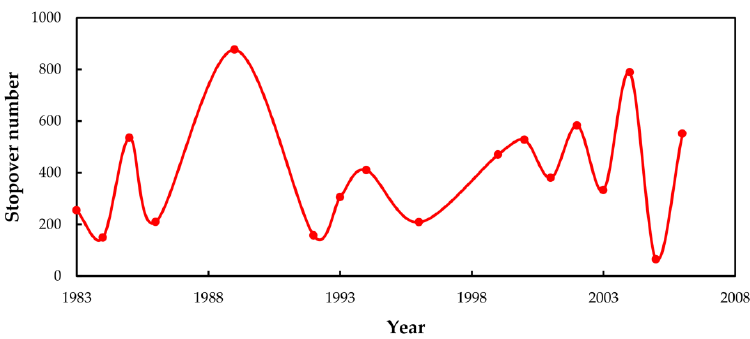
Figure 3. Stopover numbers of Siberian cranes in spring from 1983 to 2006.